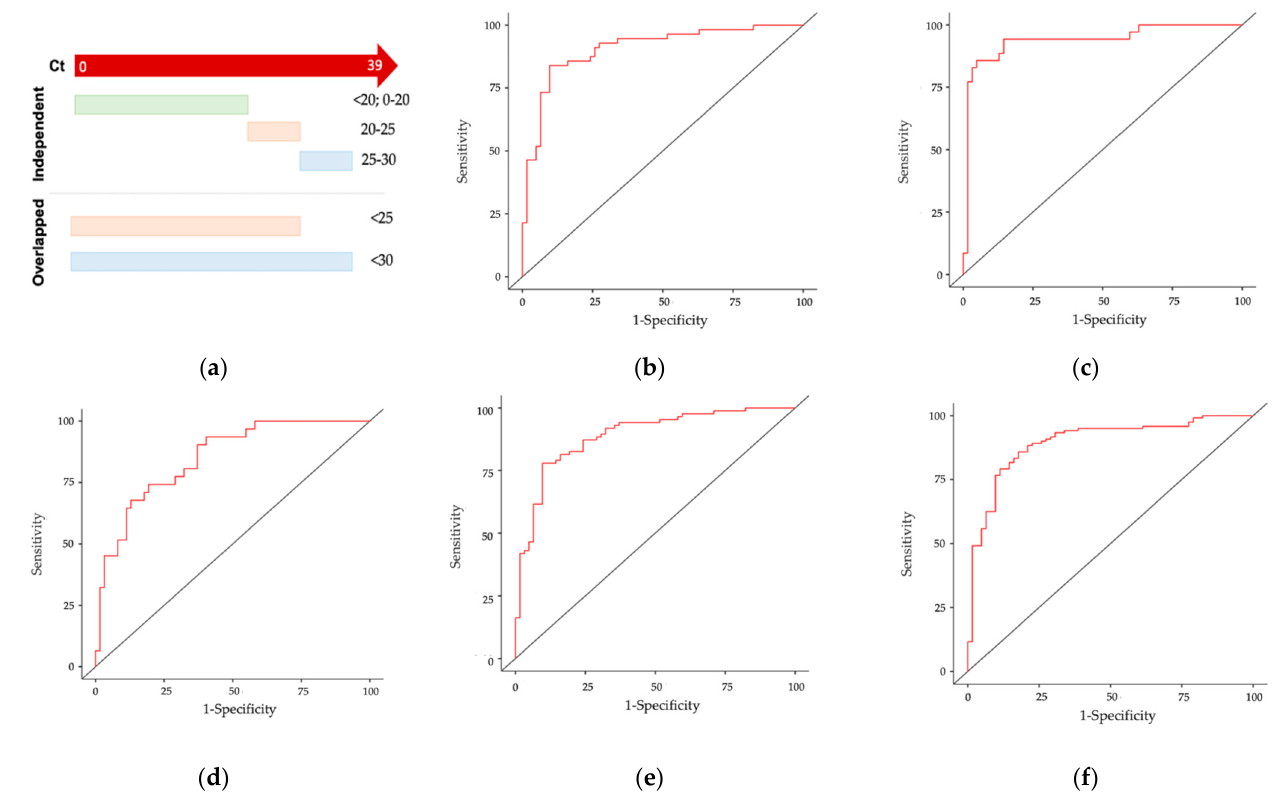
Figure 8. Recalculated ROC curves categorized by nCtOrf1ab ranges. ( a ) Scheme of Ct ranges used for curves adjustment, Red arrow: Ct scale, for independent, green bar: <20;0–20, pink bar: 20–25 and blue bar: 25–30; for overlapped, pink bar: <25, blue bar: <30. ( b ) ROC curve for Ct = 20–25, ( c ) ROC curve for Ct = 25–30 (), ( d ) ROC curve for Ct < 20, ( e ) ROC curve for Ct < 25 and ( f ) ROC curve for Ct < 30. Red lines: ROC curves, Black lines: non-discrimination lines. Table 4. Summary of diagnostic accuracy parameters obtained by Ct range. Ranges Ct